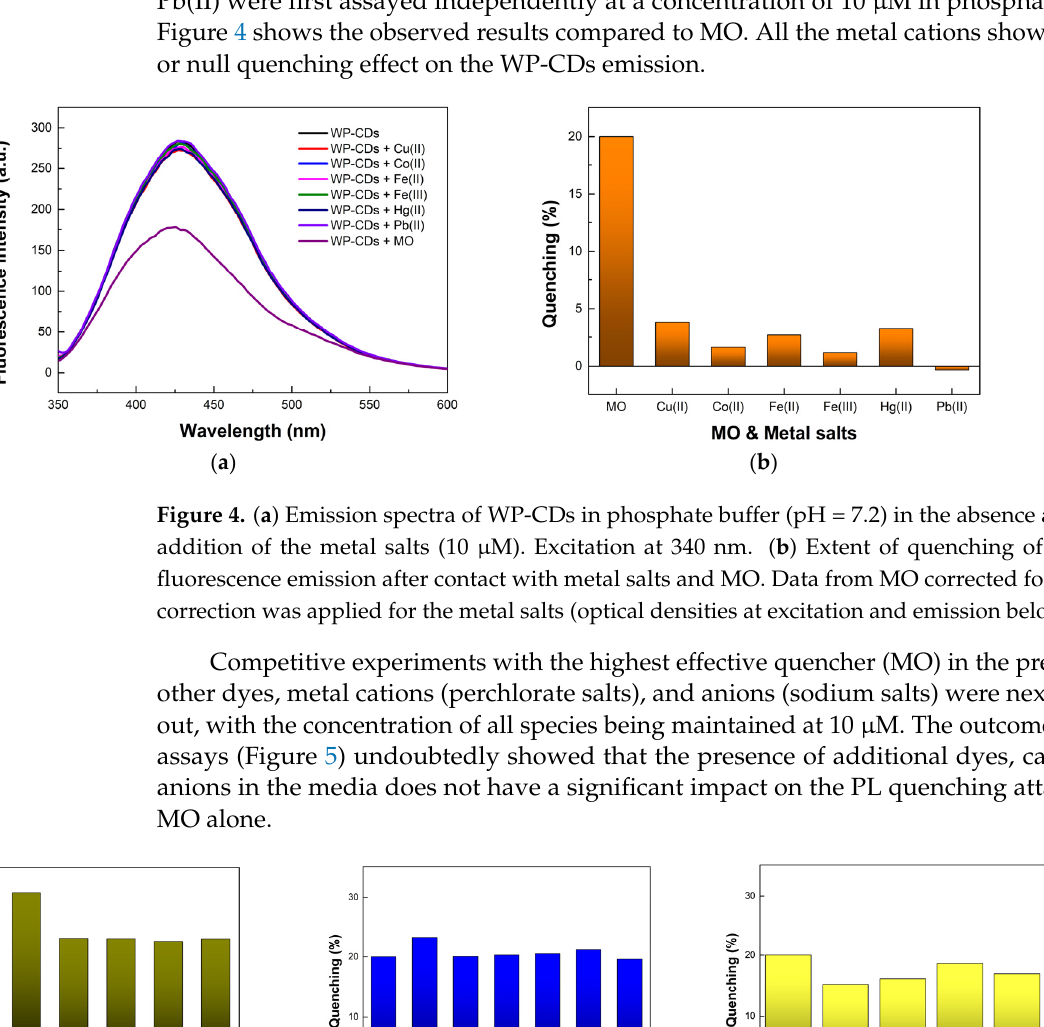
Figure 3. Quenching dependance on varying the pH (2.2, 7.2, and 11.4) of buffered solutions of WP- CDs (0.1 mg/mL) for 10 μ M of MO ( a ) and MR ( c ) and the corresponding quenching efficiencies ( b ) and ( d ). Excitation at 340 nm in acetate (pH = 2.2.), phosphate (pH = 7.2), and glycine (pH = 11.4) buffers. All data corrected for IFEs at excitation (340 nm) and emission (426 nm at pH 2.2 and 7.2 and 468 nm at pH 11.4).